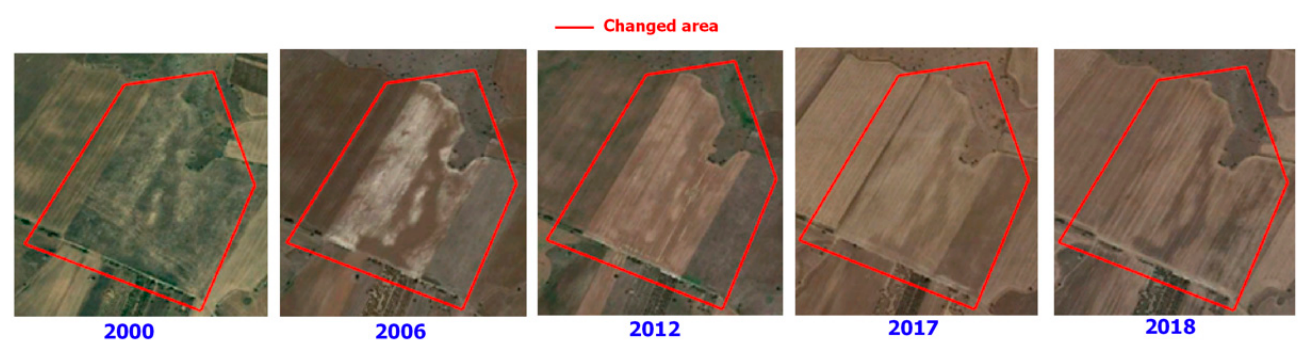
Figure 16. Time series of aerial photos from 2000 to 2018: grasslands area, within red boundary, changed into a cultivated area over